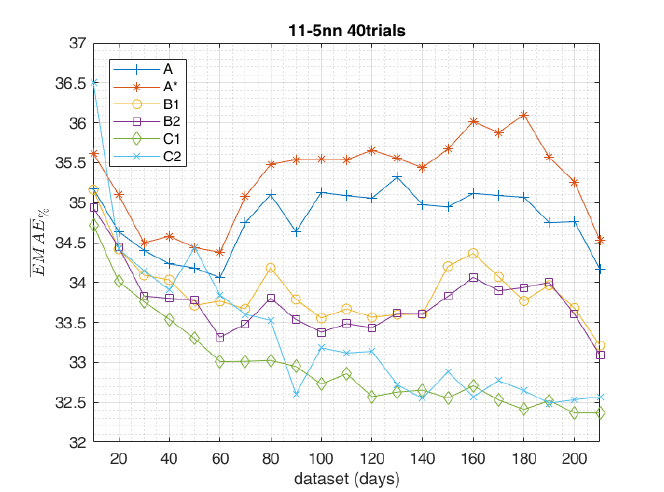
Figure 18. EMAE % as a function of the dataset